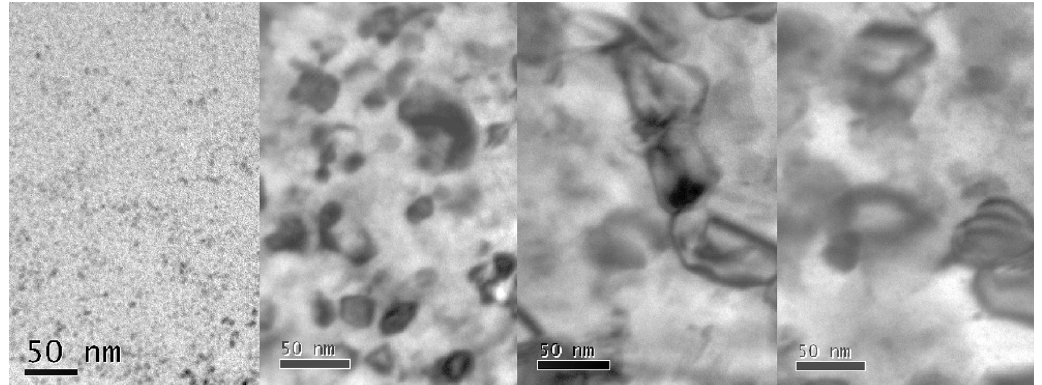
Figure 7. Structure evolution by TEM micrographs of rapidly quenched (Fe annealing 633 K in time: t